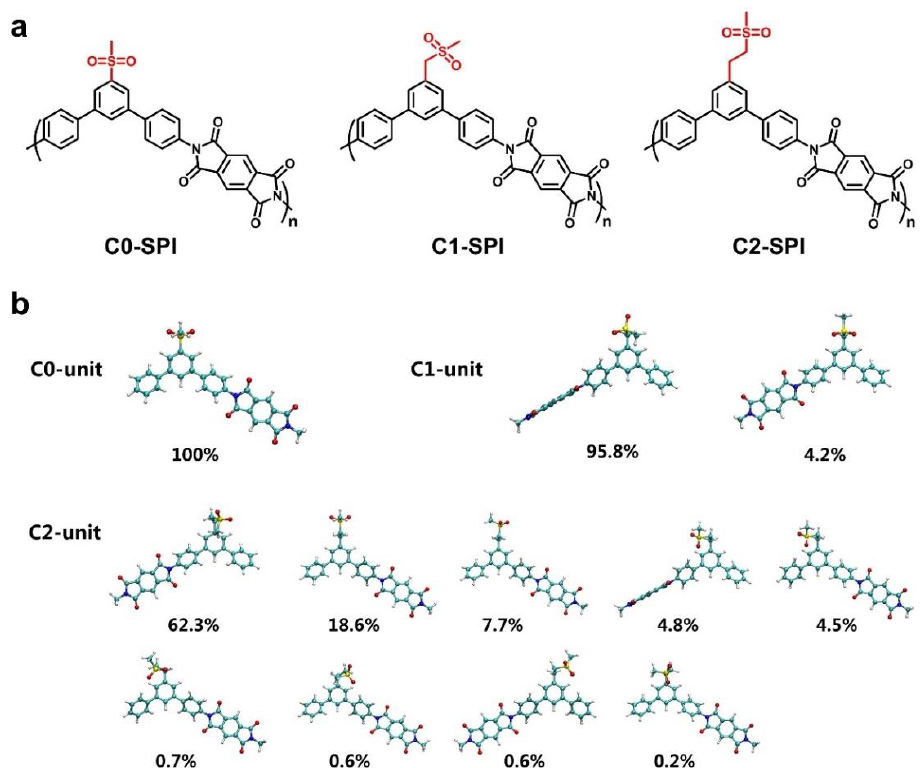
Figure 1. ( a ) Chemical structures of the three polyimides C0-SPI, C1-SPI, and C2-SPI. ( b ) Various conformations of C0 unit, C1 unit, and C2 unit. According to the Boltzmann distribution, the proportion of each conformation was calculated using their Gibbs free energy.